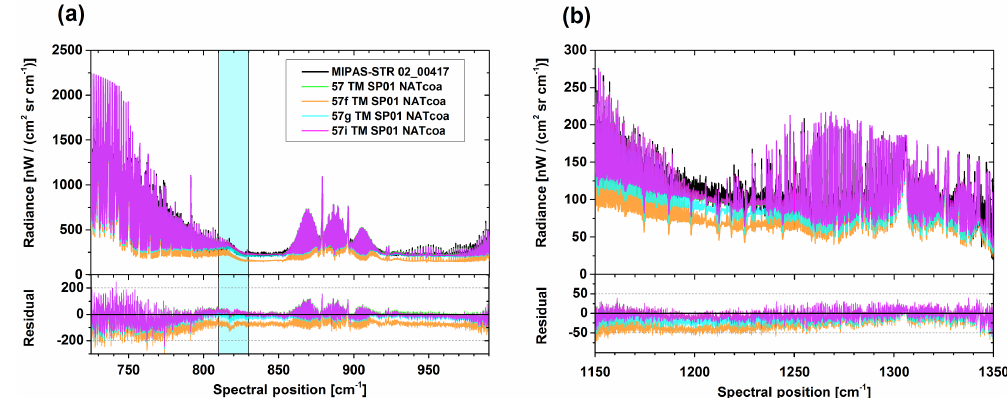
Figure 16. Influence of PSC layer thickness and particle size distribution on simulations of elongated spheroids with AR = 0.1 consisting of β -NAT. Black: MIPAS-STR limb observation (13:47UTC, tangent altitude 18.4km). Green (mostly hidden by magenta spectra): optimized scenario (assuming a vertical extent of the PSC from 17 to 23km and size distribution B). Orange: sensitivity simulation assuming a reduced vertical extent of the PSC from 17 to 20km. Cyan and magenta: sensitivity simulations using size distributions B1 and B2. Numbers in the legend refer to scenarios in Table 1. For size distributions, see Table 2 and Fig. 9b. “NATcoa” corresponds to β -NAT, “TM” to T-matrix simulation, and “SP” to spheroid (numbers indicate